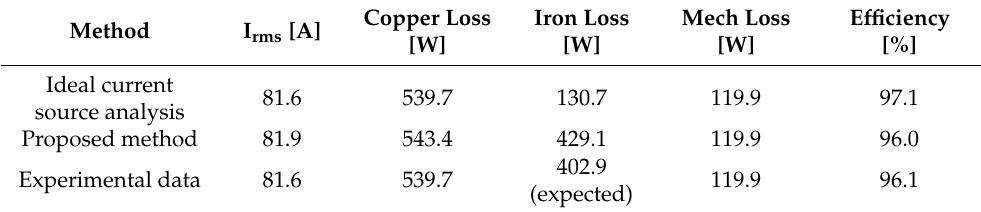
Figure 8. Iron loss comparison between the ideal current source analysis and the proposed method for cases 1 and 2. ( a ) Case 1. ( b ) Case 2. Tables 6 and 7 present the results for cases 3 and 4, respectively. Table 6. Case 3: 100 Nm at 2500 rpm.